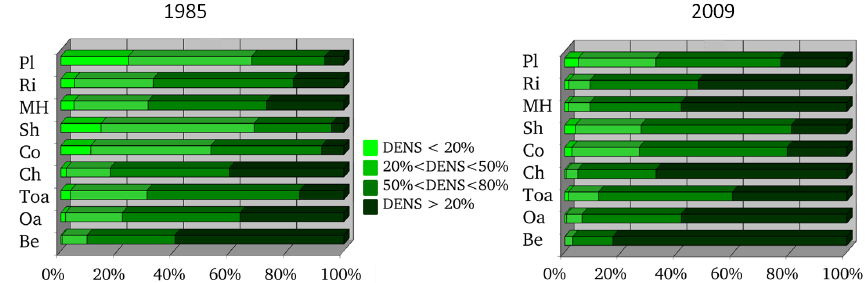
Figure 8. Bar chart displaying the segmentation of cover density per vegetation class. Values of vegetation density are derived from NDVI for the years 1985 and 2009.